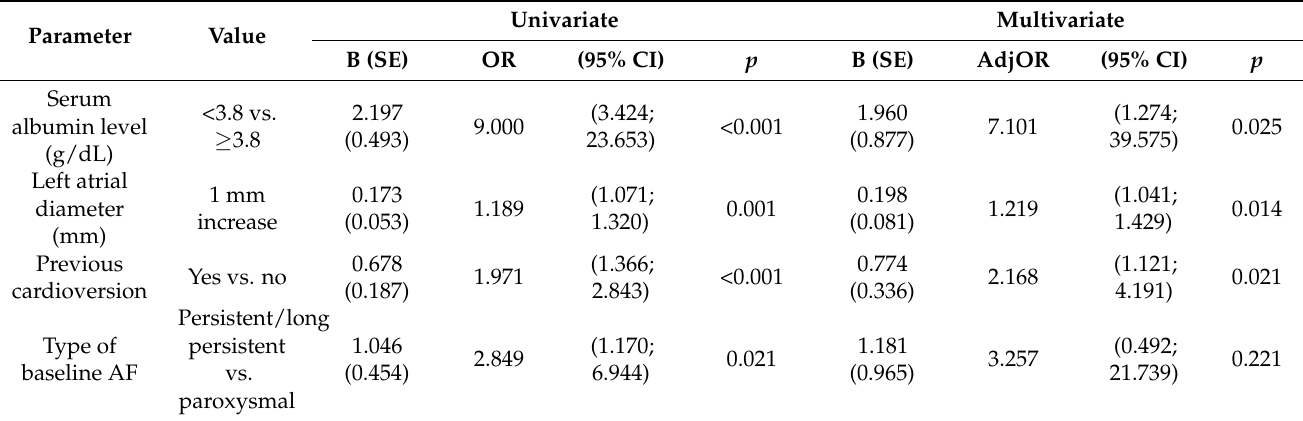
Table 5. Risk factors for atrial fibrillation (AF) recurrence following pulmonary vein isolation (PVI) ablation—univariate and multivariate